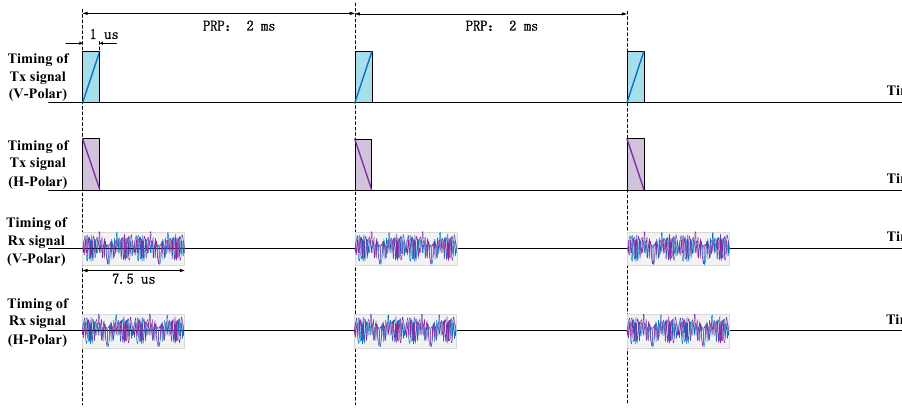
Figure 3. The sequence diagram of the fully polarimetric radar.